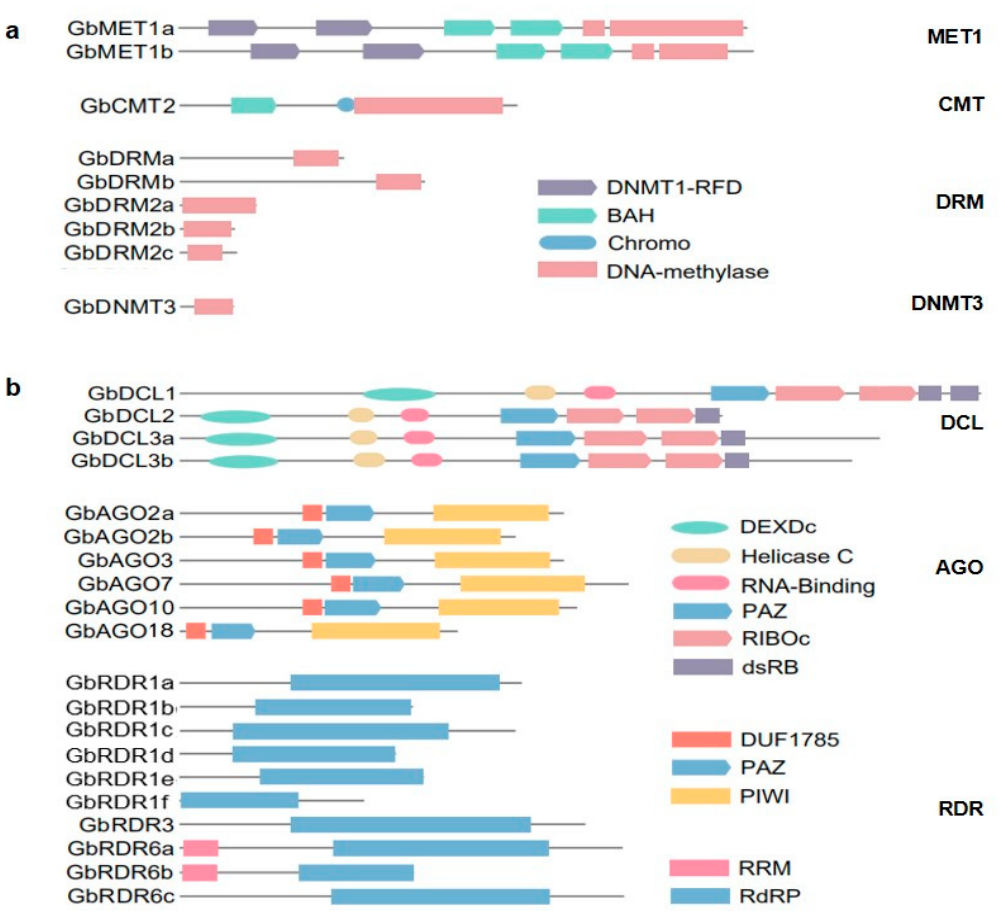
Figure 1. Conserved protein domains of di ff erent DNA methylation pathway gene families in G. biloba . ( a ) Nine DNA methyltransferases (GbDNMTs), and ( b ) three families involved in the RNA-directed DNA methylation (RdDM) pathway.